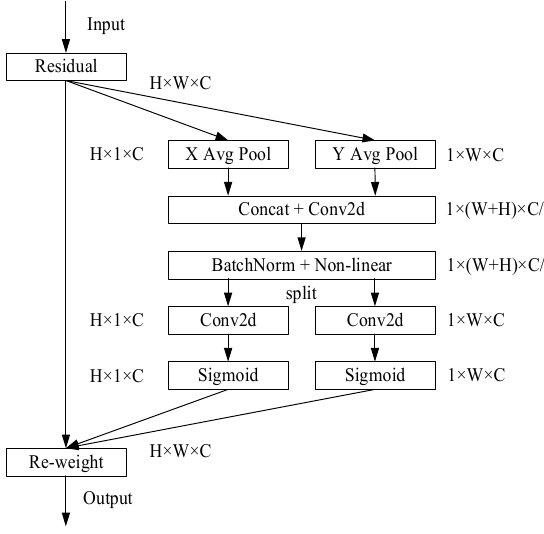
Figure 4. The coordinate attention module.